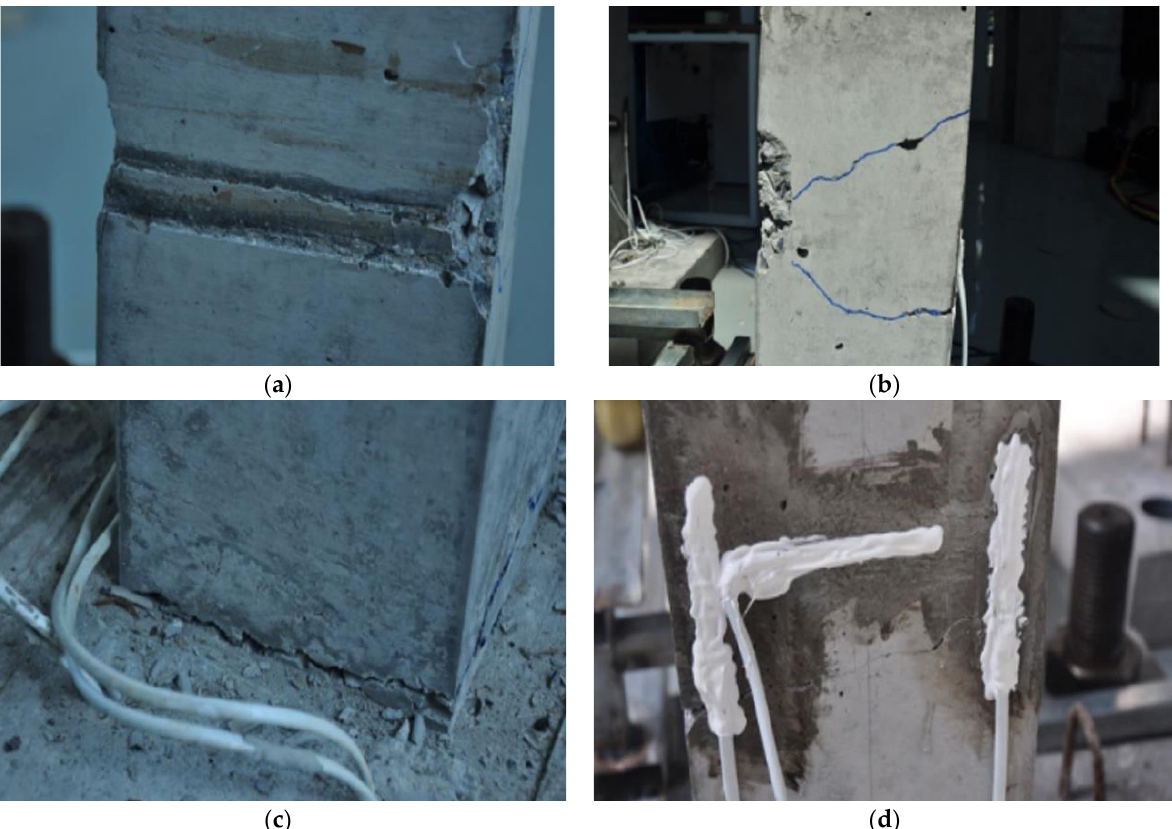
Figure 6. Damage area of C_1: ( a ) concrete falling off at the impact contact position; ( b ) concrete cracking at the impact contact position; ( c ) concrete cracking at the column bottom; and ( d ) concrete cracking at the backside of the contact position.